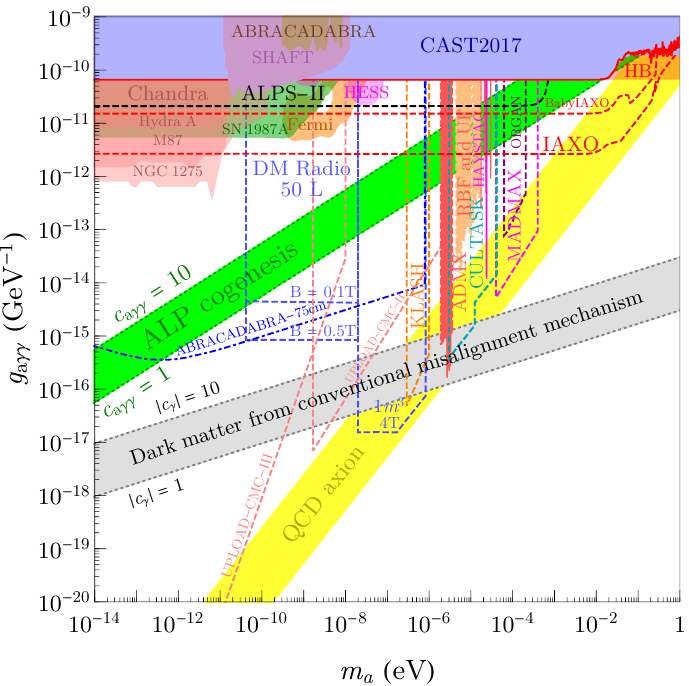
Figure 1 . The prediction for the ALP-photon coupling g a(cid:13)(cid:13) is shown by the green band, for c a(cid:13)(cid:13) = 1 (cid:0) 10. The predictions for the QCD axion and for ALP dark matter from the conventional misalignment mechanism are shown in the yellow and gray bands. Other shaded regions denote the existing experimental constraints, while various lines show the sensitivity of future